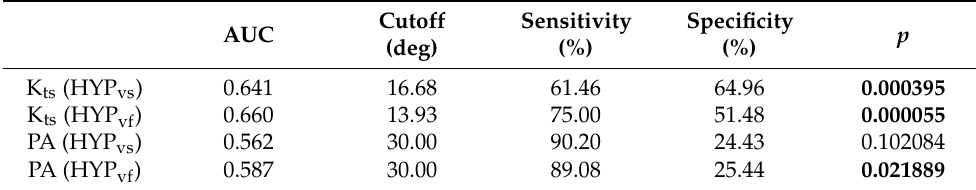
Table 3. The cutoff values of popliteal angle (PA) and knee angle at the end of swing/initial stance (K ts ) during gait to detect the presence of knee flexors hypertonia based on two clinical tests: TAS at slow (HYP vs ) and TAS fast (HYP vf ) velocities. AUC (deg) Cutoff AUC (deg)